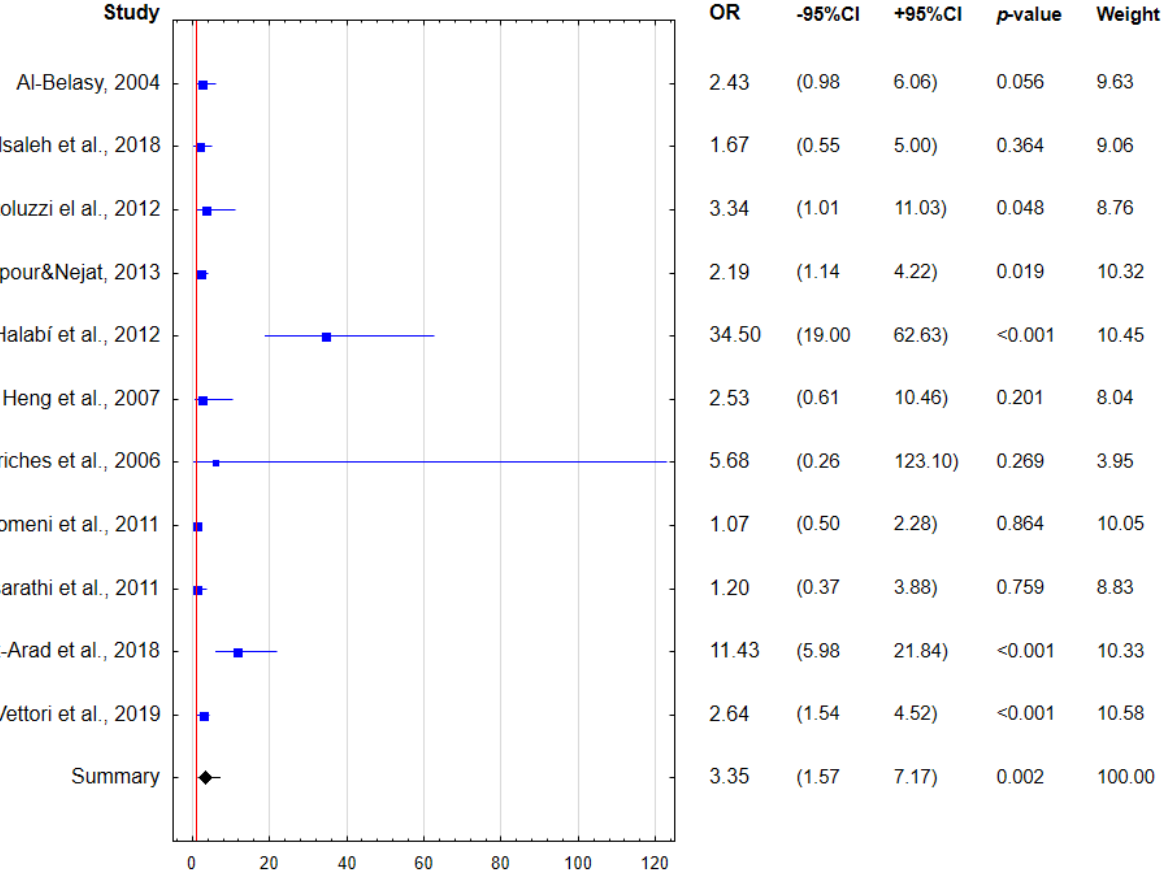
Figure 5. Forest plot presenting the odds for dry socket considering regular smoking (OR—odds ratio; CI—confidence interval) [21–31].